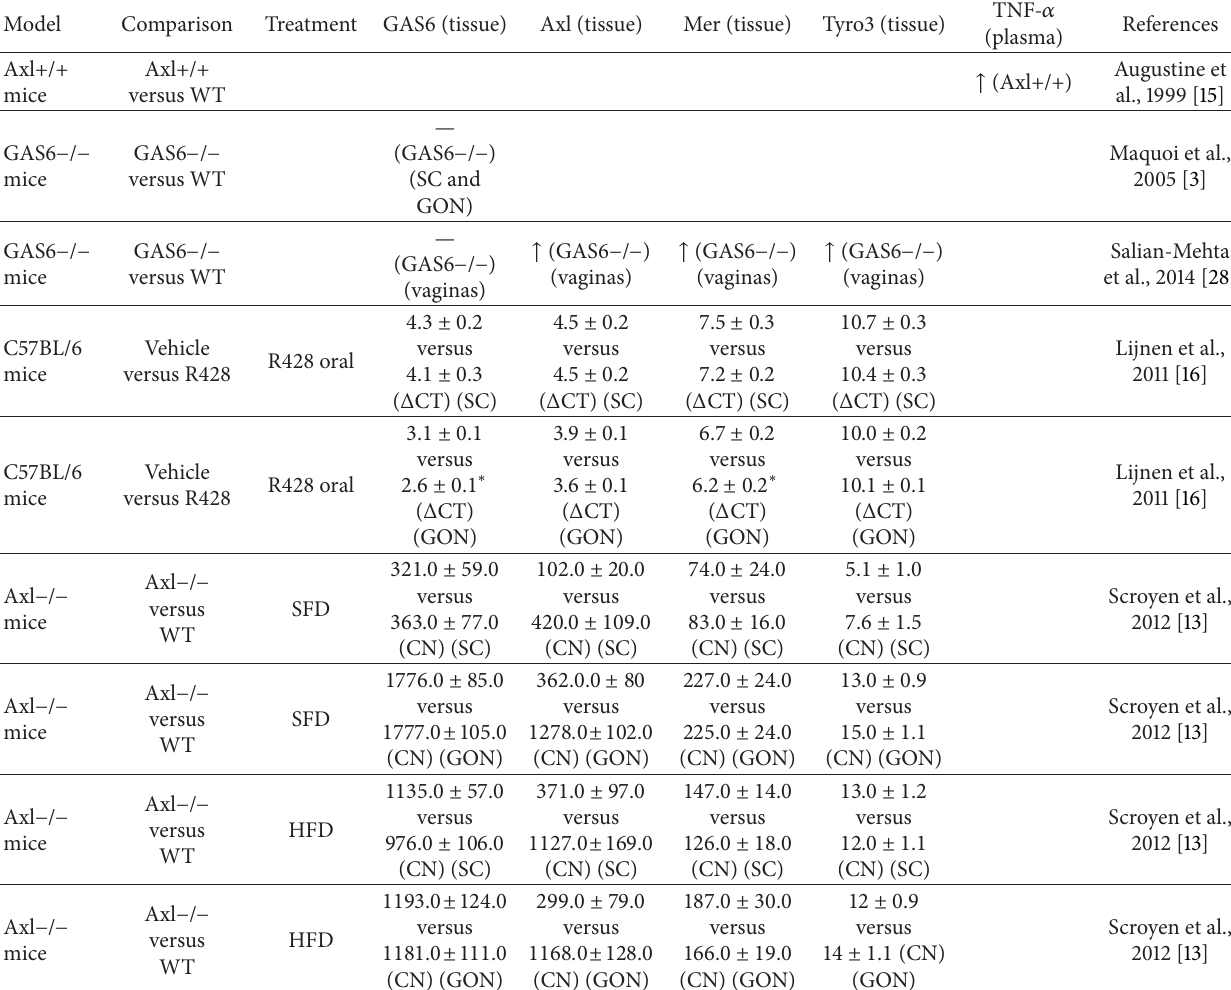
Table 3: GAS6 signaling molecules and the development of obesity-associated inflammation in mouse model.